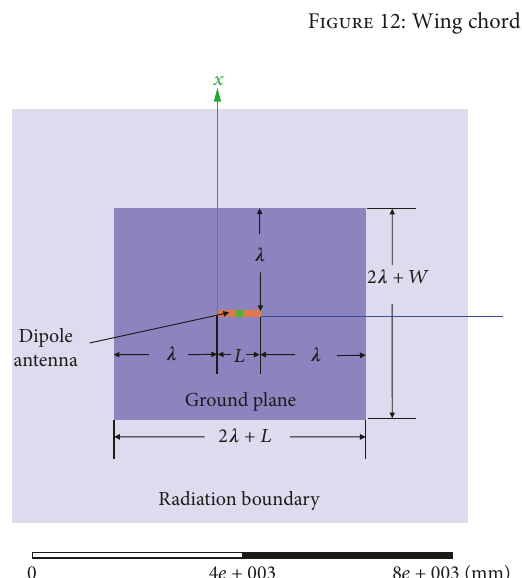
Figure 12: Wing chord geometry associated with (3) and (4).